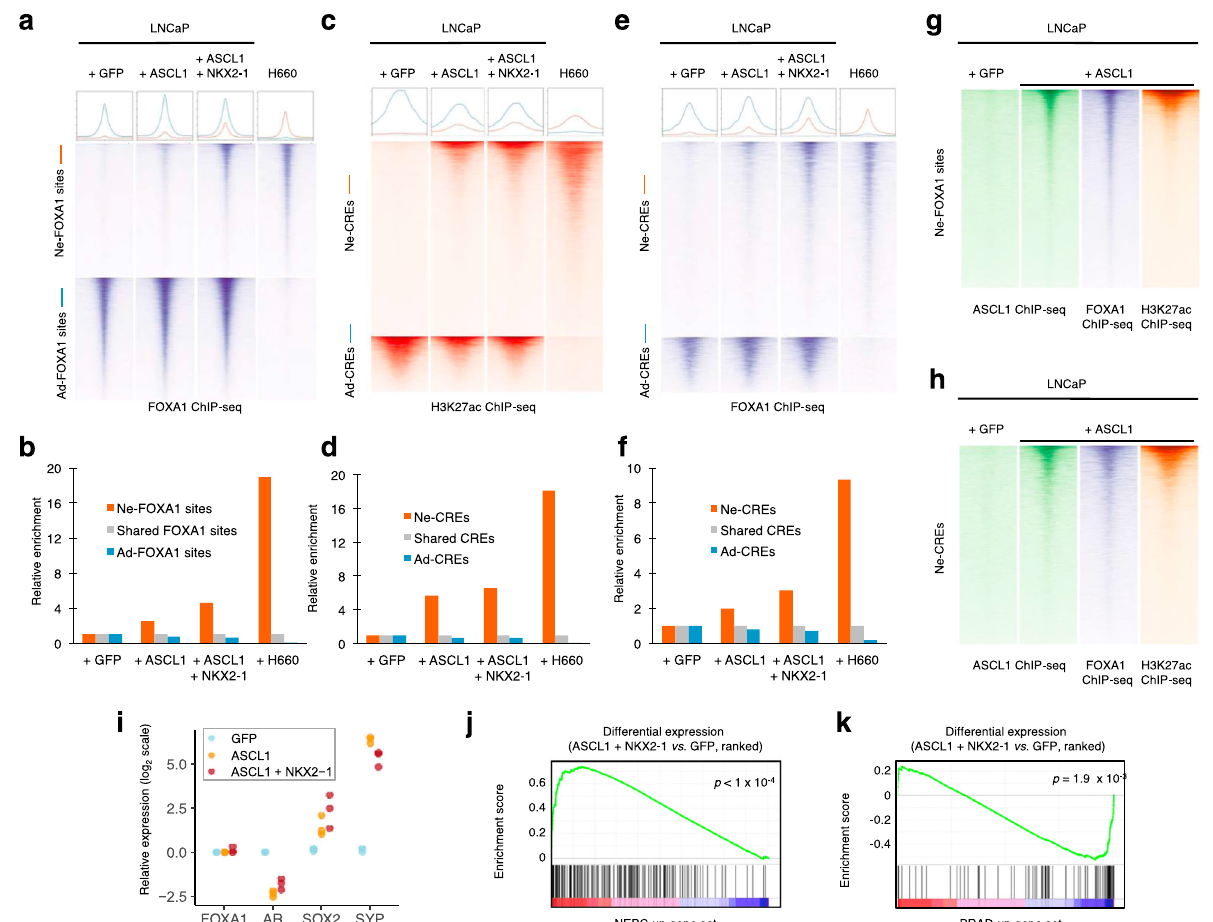
Fig. 4 FOXA1 is extensively redistributed at lineage-speci fi c regulatory elements. a Normalized ChIP-seq tag density for FOXA1 at NEPC-enriched and PRAD-enriched FOXA1-binding sites under the indicated conditions. Pro fi le plots (top) represent mean tag density at sites depicted in the heatmaps. b Enrichment of FOXA1 peaks for overlap with NEPC-enriched and PRAD-enriched FOXA1-binding sites in the indicated conditions, normalized to FOXA1 peaks shared between PRAD and NEPC. c – f Normalized ChIP-seq tag density for H3K27ac ( c ) and FOXA1 ( e ) at Ne-CREs and Ad-CREs under the indicated experimental conditions. Enrichment of overlap of H3K27ac peaks ( d ) and FOXA1 peaks ( f ) with Ne-CREs and Ad-CREs under the indicated conditions. g – h Normalized ChIP-seq tag density for ASCL1, FOXA1, and H3K27ac under the indicate experimental conditions at NEPC-enriched FOXA1 sites ( g ) and Ne- CREs ( h ). i Effect of ASCL1 overexpression on transcript levels of indicated genes, measured by qPCR. Fold-change relative to + GFP condition is shown, using normalization to GAPDH. Three biological replicates are shown for each condition. j – k Gene set enrichment analysis of genes upregulated at least 8- fold in LuCaP NEPC ( j ) or PRAD ( k ) at adjusted p -value < 10 − 18 . Genes are ranked by differential expression between LNCaP + ASCL1 + NKX2-1 and + GFP conditions based on RNA-seq. Unadjusted permutation-based one-sided p -values for enrichment are shown. Source data are provided as a Source Data fi